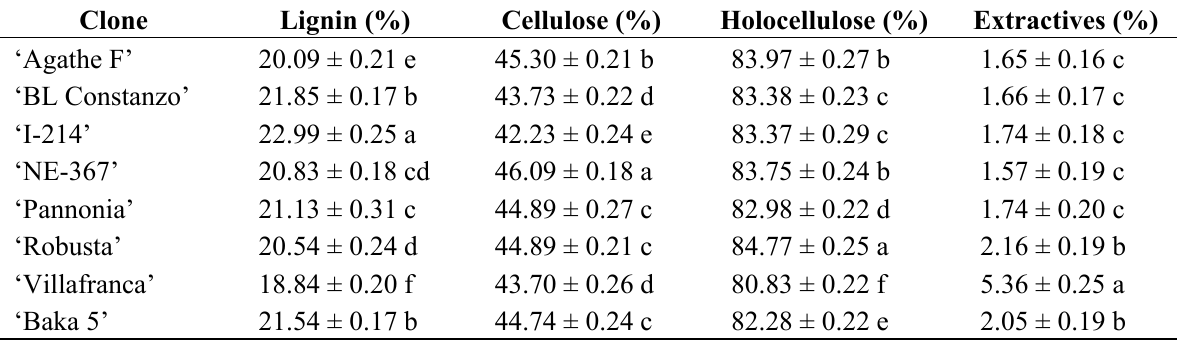
Table 2. The content of main wood components and extractives present in the examined clones of Populus grown on the Selice experimental site. Data represent percentages of oven dry weight (odw) (mean ± SD).